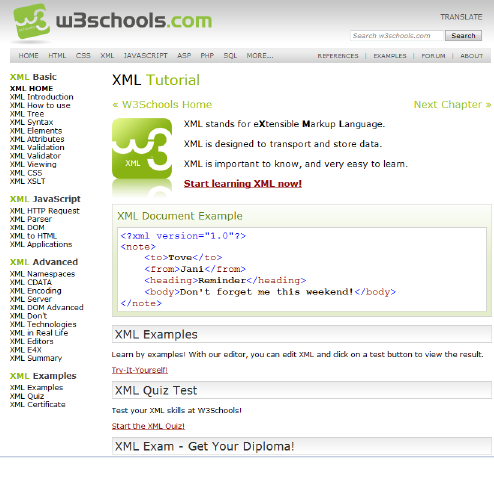
Figure 6: w3schools – XML tutorial